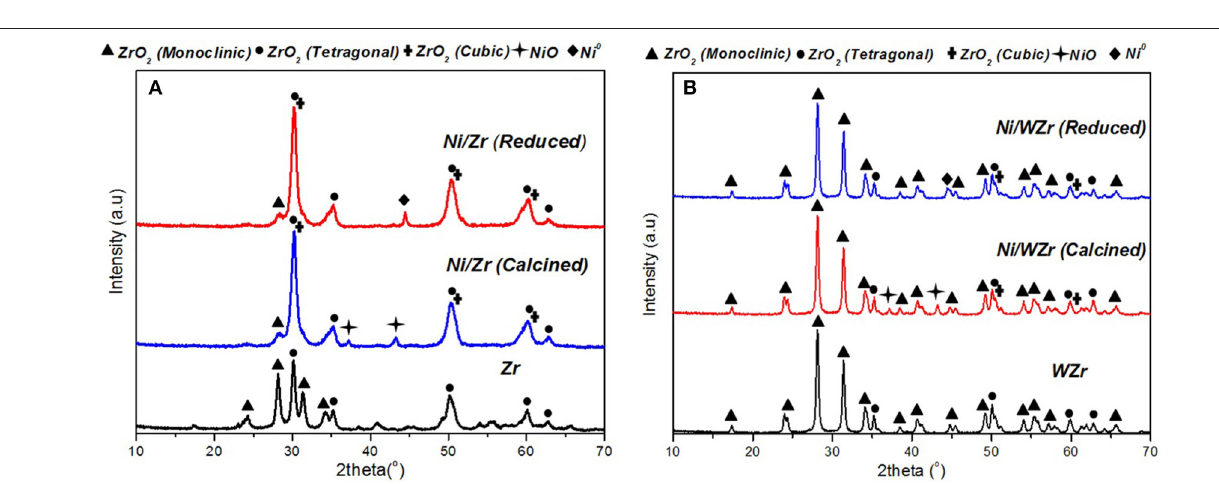
FIGURE 2 | XRD patterns of calcined supports and calcined and reduced samples: (A) Ni/Zr, (B) Ni/WZr ( λ = 0.154178nm, 2 θ = 2–70 ◦ , Scanning rate: 0.04 ◦ over 1.2 min − 1